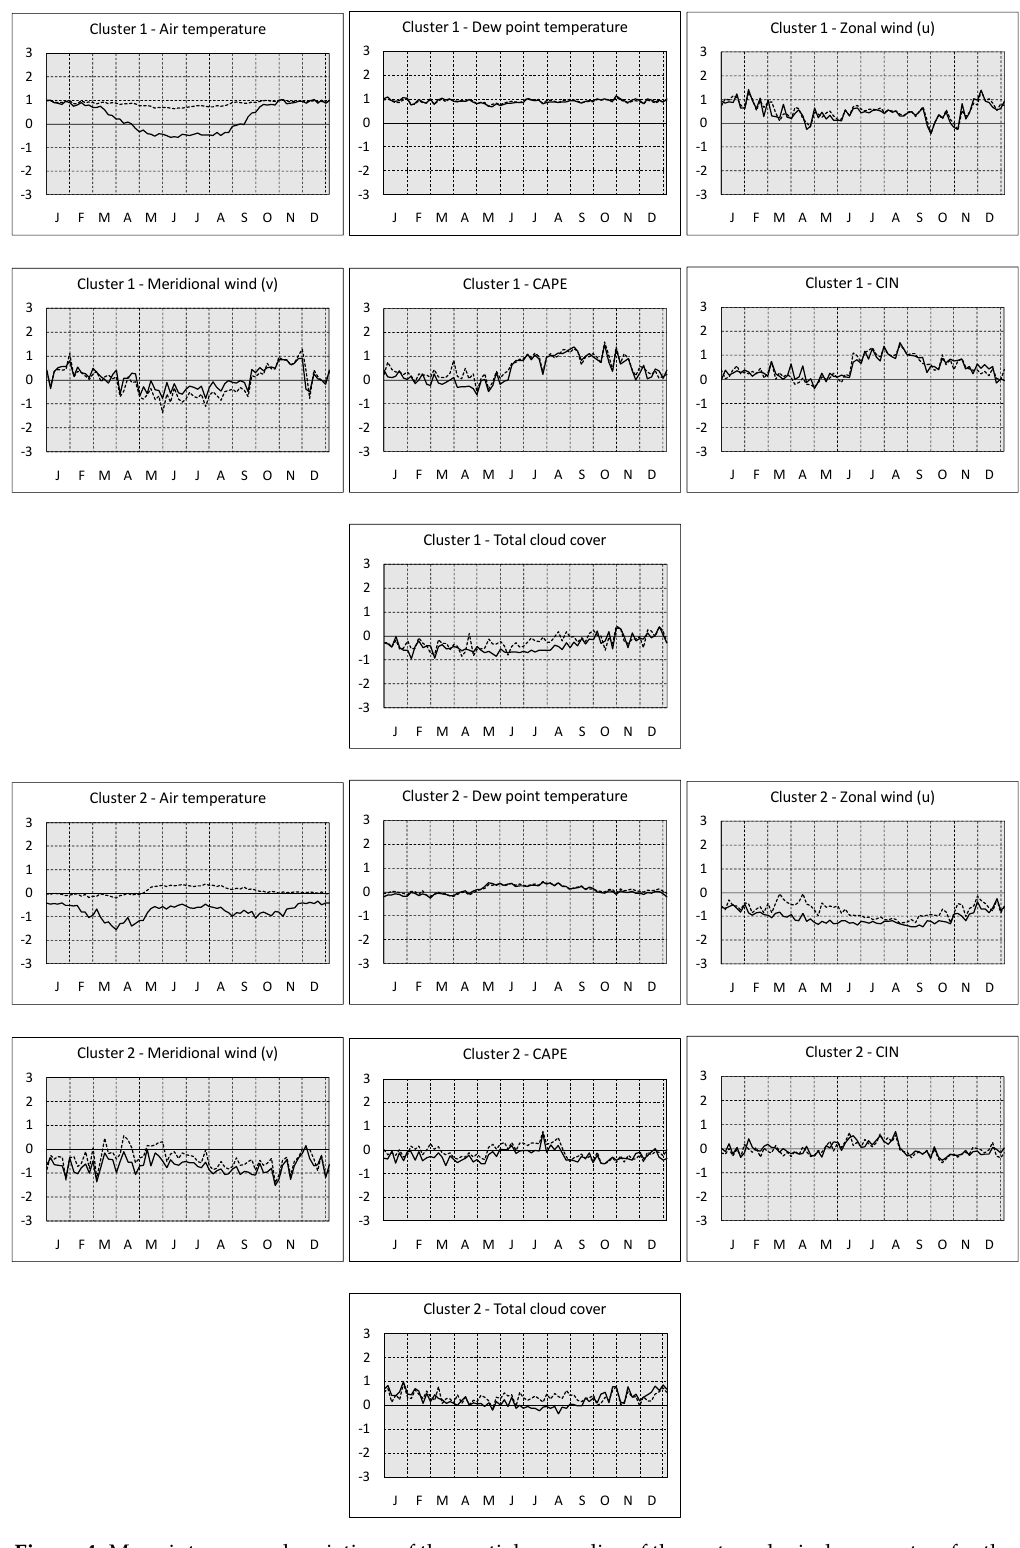
Figure 4. Mean intra-annual variations of the spatial anomalies of the meteorological parameters for the areas of clusters 1 and 2. Continuous and dashed lines correspond to 12UTC and 00UTC respectively.